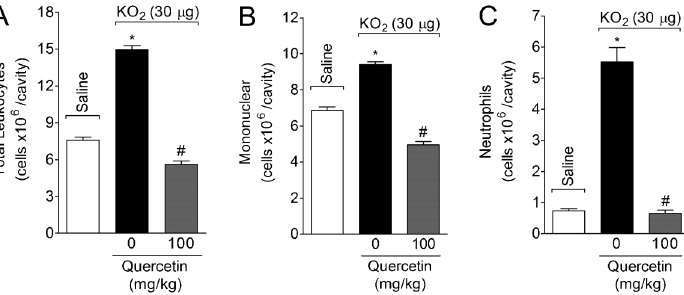
Figure 8. Quercetin inhibited the KO 2 -induced leukocyte recruitment. Mice were treated with quercetin (100 mg/kg, ip ) or vehicle 1 h before KO 2 (30 m g, ip ) injection. The total number of leukocytes ( A ), mononuclear cells ( B ), and neutrophils ( C ) were determined 6 h after stimu- lus. Data are reported as means±SE. *P , 0.05 vs saline control; # P , 0.05 vs KO 2 control (one- way ANOVA followed by Tukey’s t